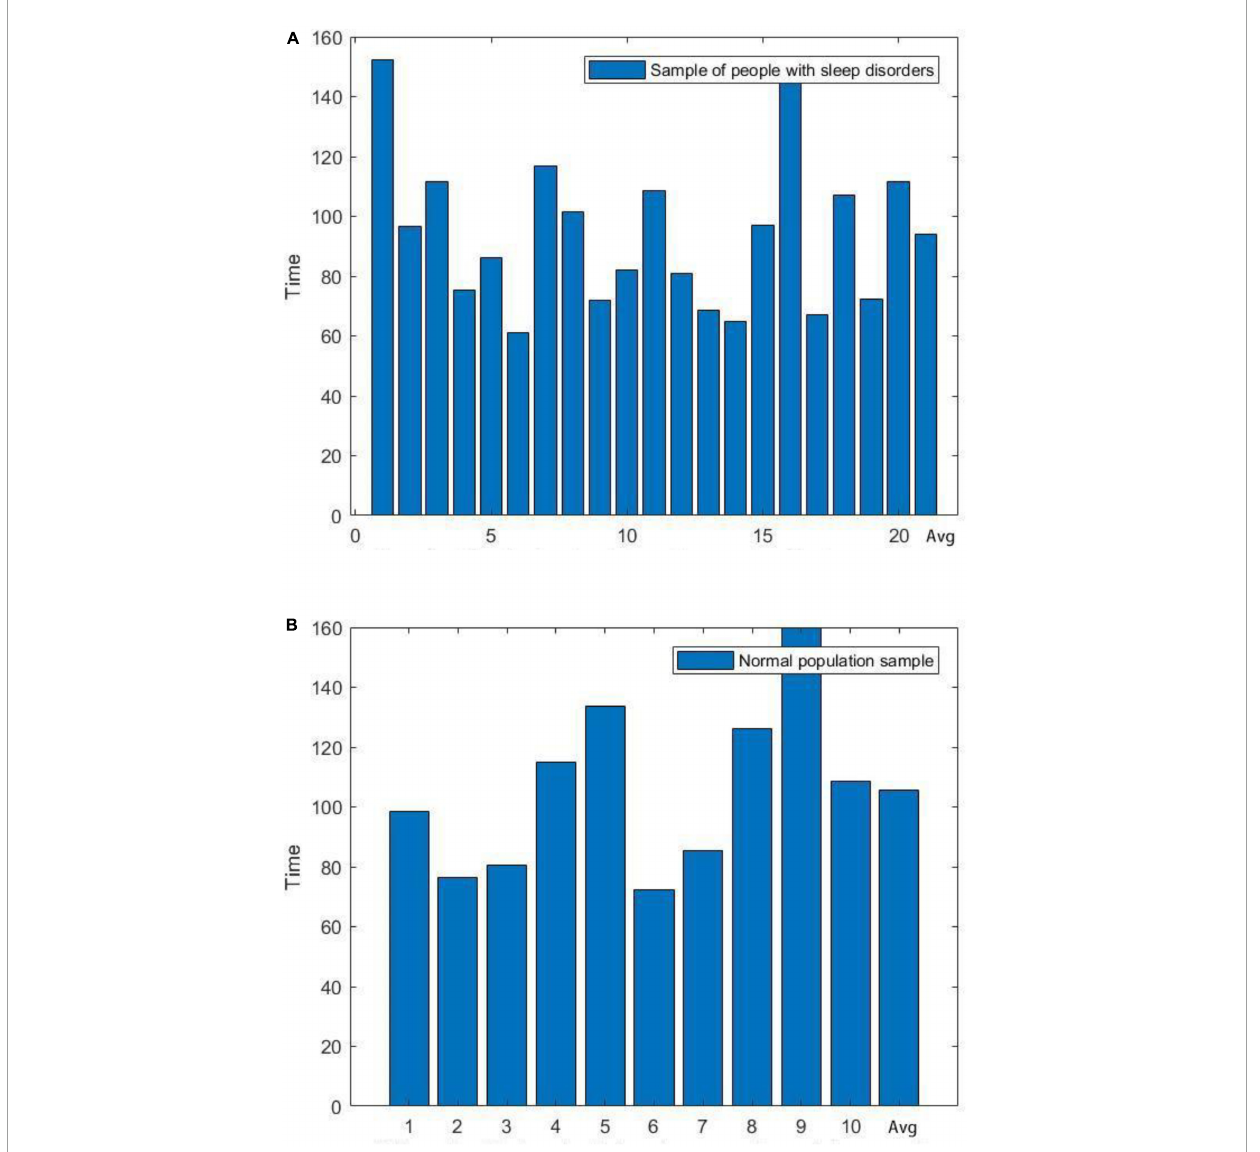
FIGURE3 Comparison of the length of the first cycle of sleep between sleep-disordered and normal subjects. (A) Length of the first cycle of sleep for people with sleep disorders. (B) Length of the first cycle of sleep in a normal population